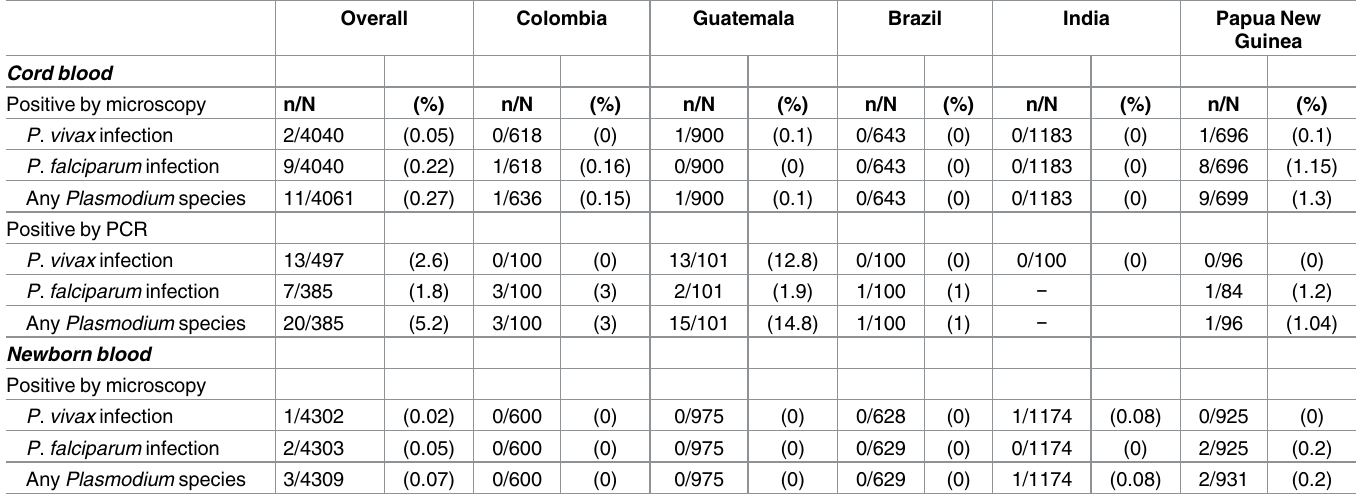
Table 4. Congenital malaria cases per